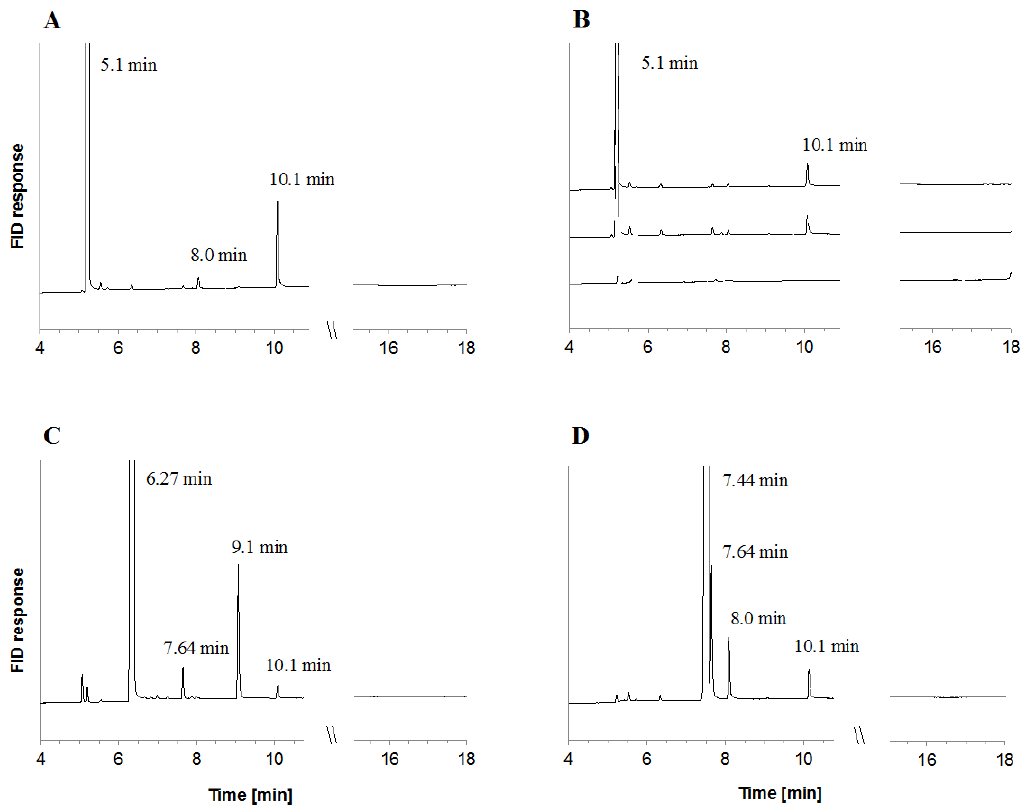
Figure 2. Metabolites formed in vitro from α-pinene ( A , B ), sabinene ( C ) and 3-carene ( D ) by dialyzed cell lysates of pinene-grown C. defragrans 65Phen. The y -axis has the same scale in all graphs; ( B ) terpinolene formation from α-pinene was hampered after EDTA addition (25 mM) (solid line) or in the absence of divalent cations and ATP (dashed line); the cell lysate did not contain monoterpenes (dotted line). Monoterpenes were identified by GC-MS, standard addition analysis and retention time comparison with authentic standards: α -pinene (5.1 min), sabinene (6.27 min), 3-carene (7.44 min) α -terpinene (7.64 min), limonene (8.0 min), γ -terpinene (9.1 min) and terpinolene (10.1 min).